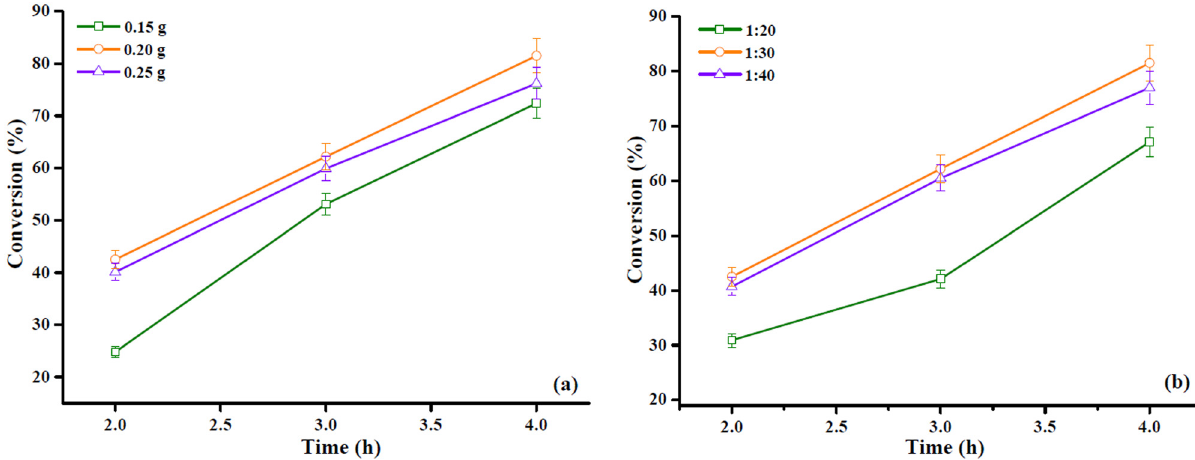
Figure 8: Study of e ff ects of ( a ) amount of Ce - BDC@HSiW@UiO - 66 and ( b ) mole ratio on the conversion of oleic acid.